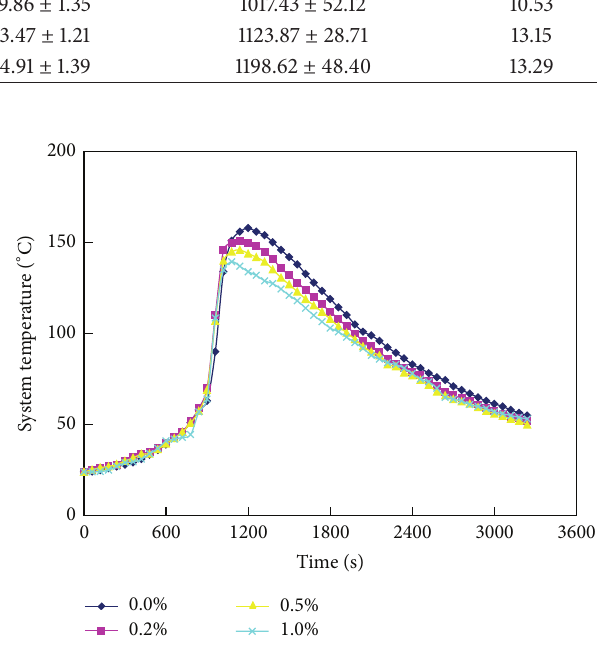
Figure 3: Temperature associated with the curing reaction of the base materials prepared with varying nanodiamond contents.